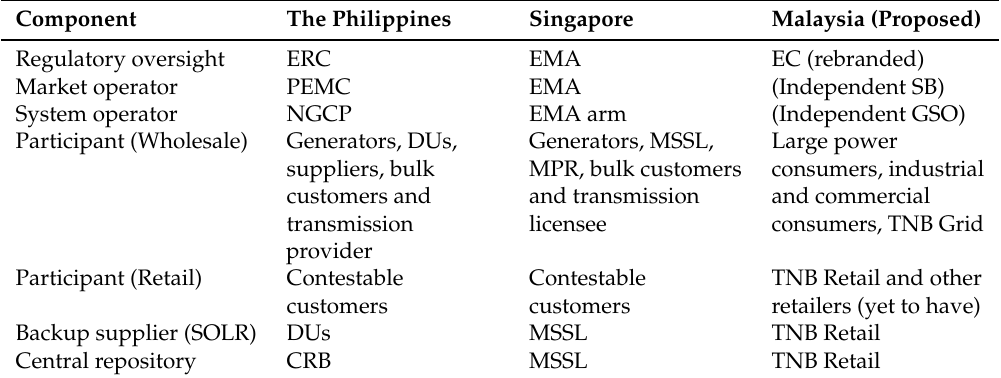
Table 8. Components in an electricity